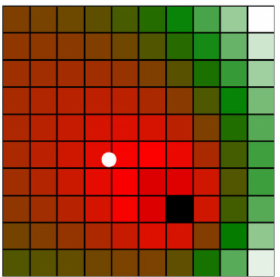
Figure 8. Example of a center of gravity (drawn as a white dot) of a simplified 2D voxel